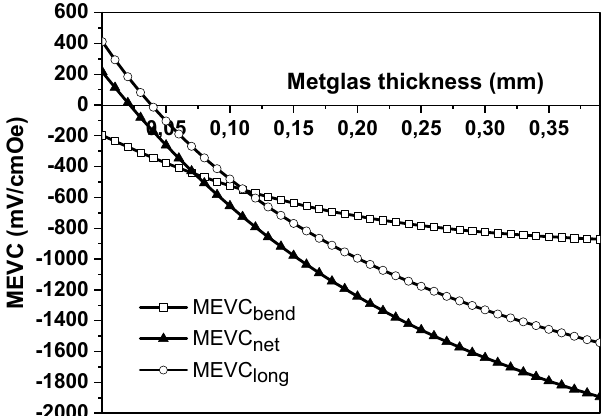
Figure 4. Estimated dependence of MEVC in a Ni-Metglas-PZT second-type three-layered structure on the Metglas layer thickness. The PZT layer thickness t p = 0.2 mm, the Ni thickness t m 1 = 0.2 mm.